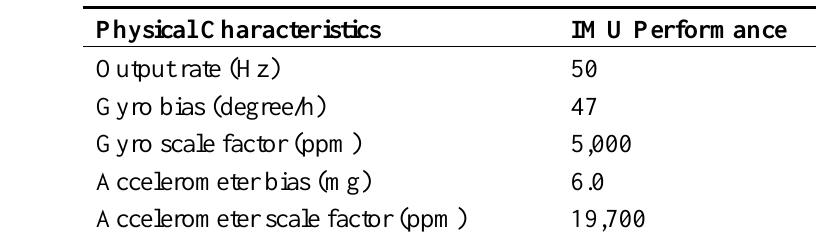
Table 1. MIDG II